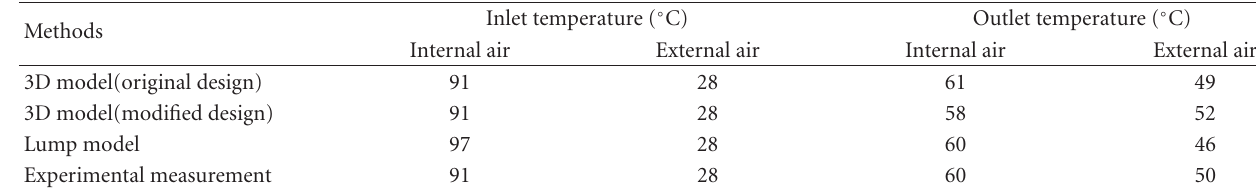
Table 3: Average inlet and outlet temperatures of internal and external air flows.